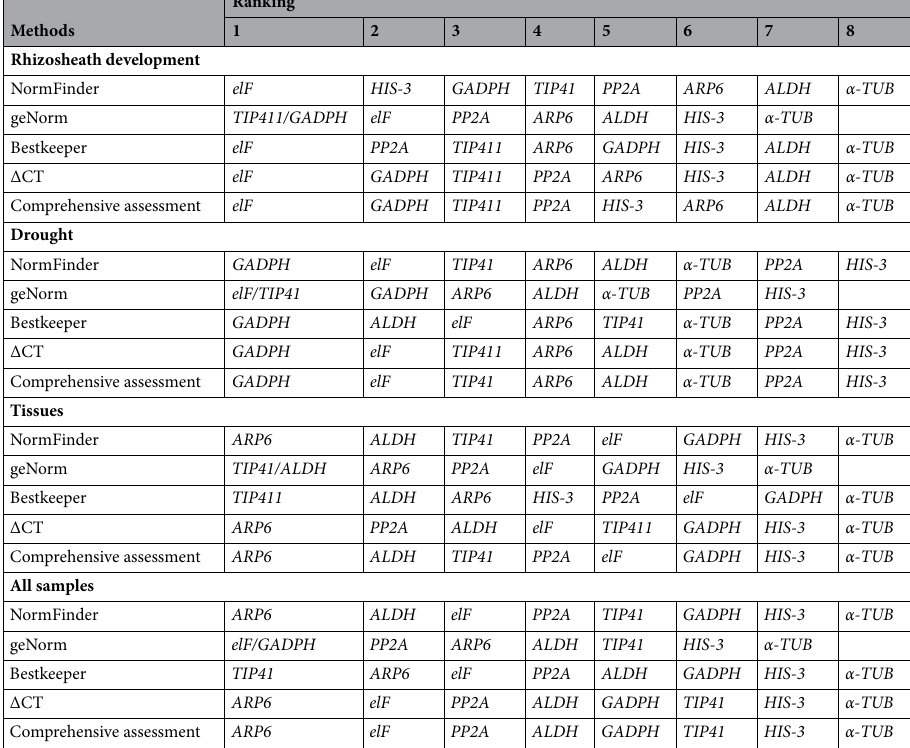
Table 4. Comprehensive assessment ranking of the expression stability for the eight candidate reference